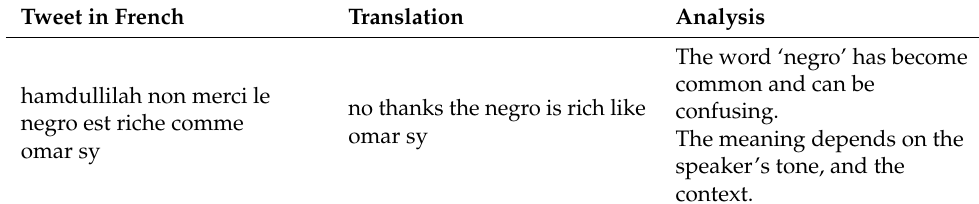
Table 11. Error analysis—false